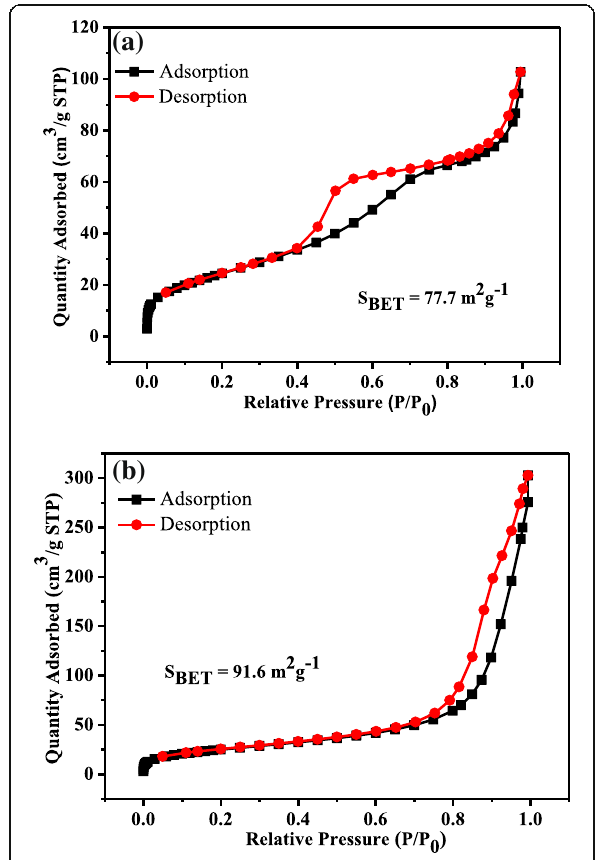
Fig. 4 Nitrogen absorption-desorption isotherms of a TiO 2 (S)/CdTe/ BiOI and b TiO 2